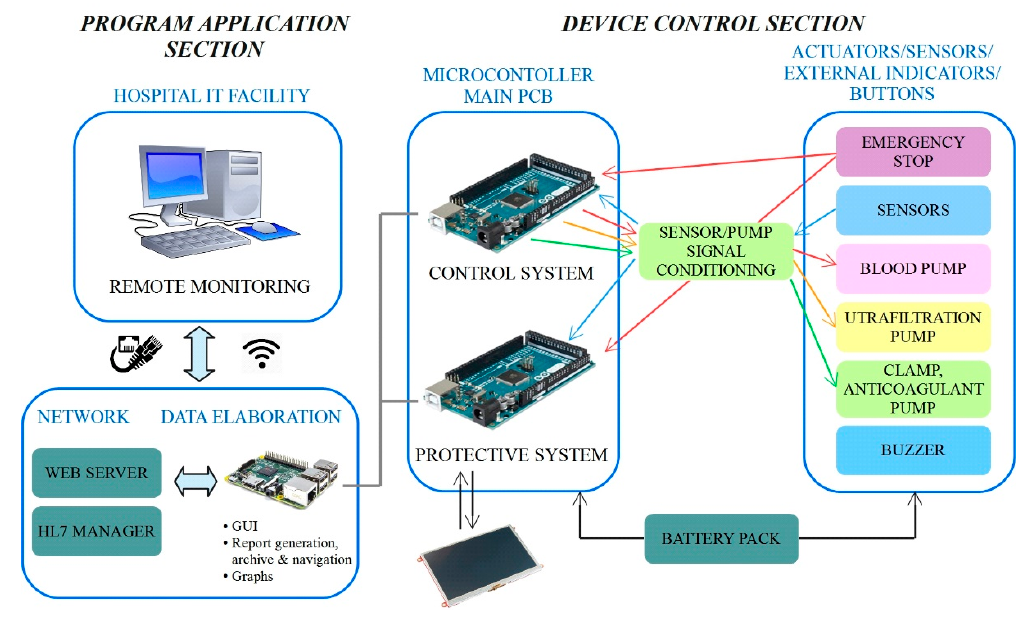
Figure 6. RAP control architecture.